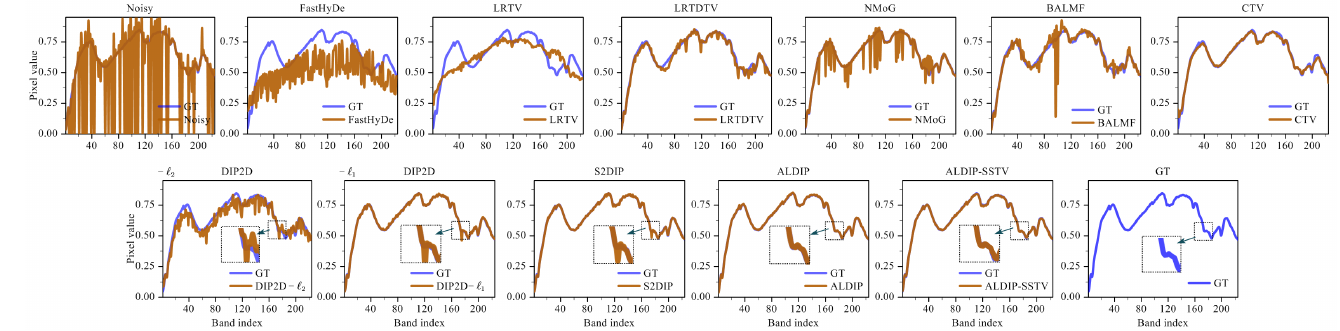
Figure 6. Spectral curves of methods for comparison at pixel (67,7) on Indian Pines dataset (case 9). Pixel (52,59) on the Pavia Centre dataset for case 12 is also selected. In Figure 7, it is clear that ALDIP and ALDIP-SSTV finely recover the truth spectrum. Therefore, our proposed ALDIP and ALDIP-SSTV are able to achieve a restoration closest to the truth.